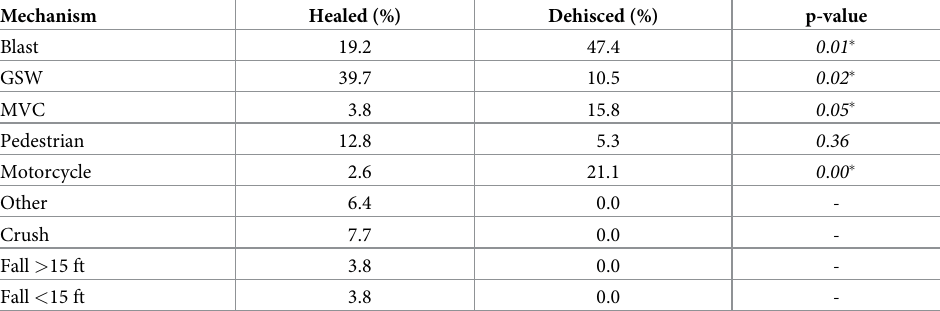
Chi-squared tests could not be calculated for Other, Crush, and Falls. (cid:3) A p-value (cid:20) 0.05 indicates statistical significance.